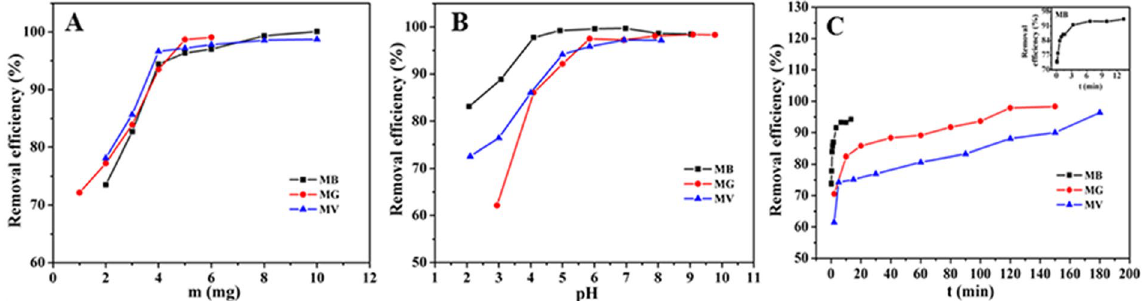
Figure 3. Effect of dosage ( A ), pH ( B ) and contact time ( C ) on adsorption behavior of MB, MG and MV ( C 0 = 40 mg L − 1 , V = 10 mL, temperature was 298